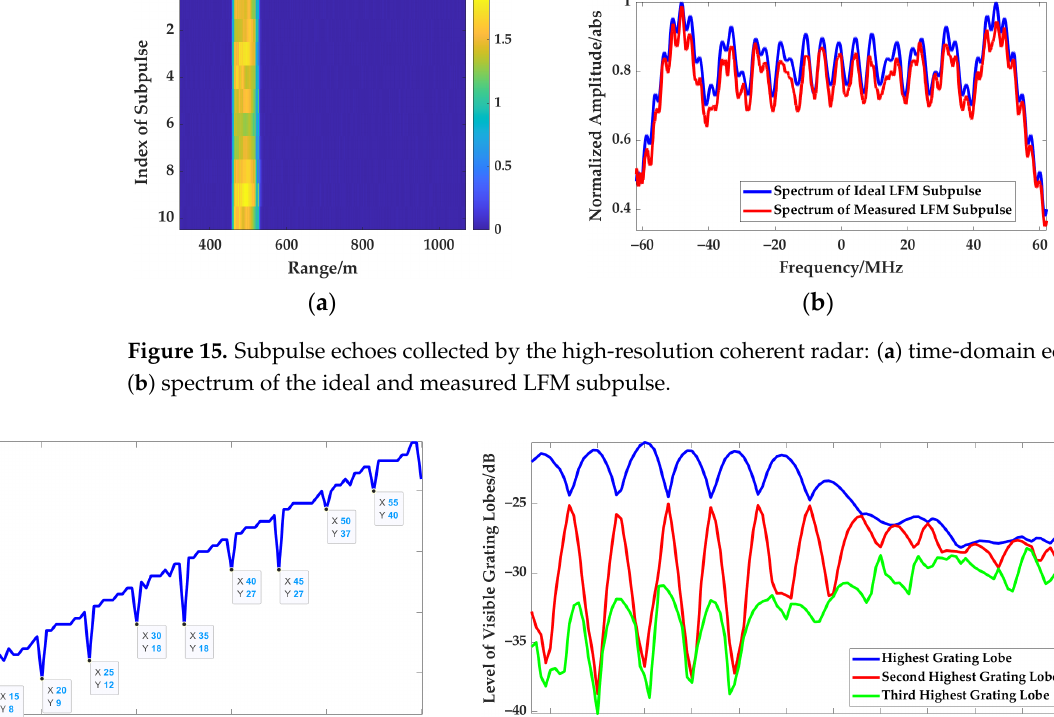
Figure 15. Subpulse echoes collected by the high-resolution coherent radar: ( a ) time-domain ech-